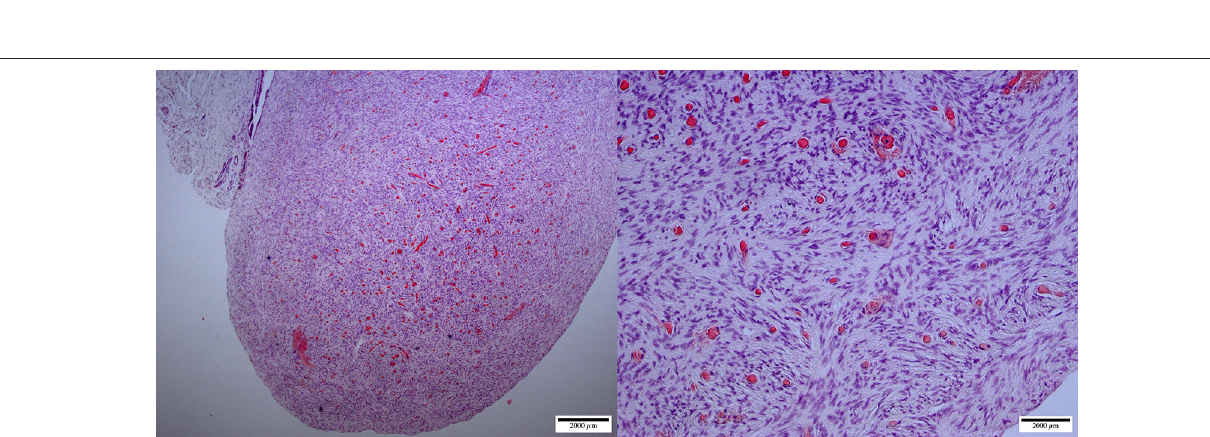
FIGURE 6 | Ovarian hypoplasia (streak gonad): micrographs at lower (left, × 40) and higher (right, × 200) magnification of the ovary. Thick dense tissue with diffuse cortex and medulla containing a dispersed network of vascular structures. The cortex is devoid of any oocyte/follicular structures (H&E staining).